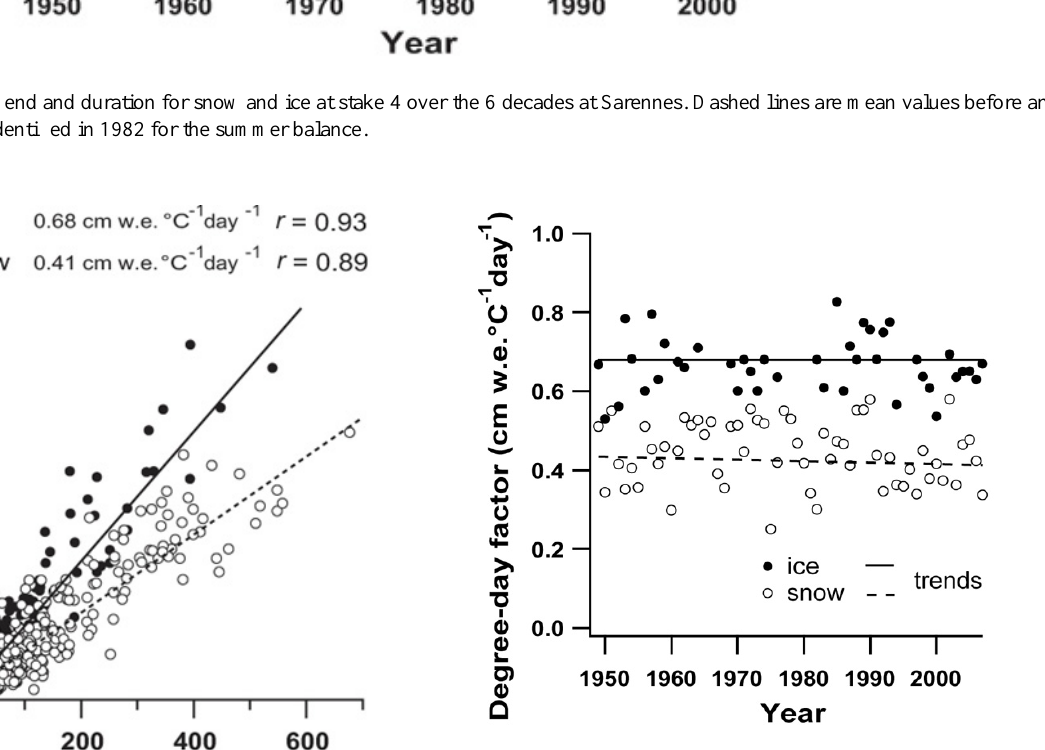
Fig. 11. Degree-day factors for snow and ice along the 6 decades at Sarennes at stake 4. Lines refer to trends which are not